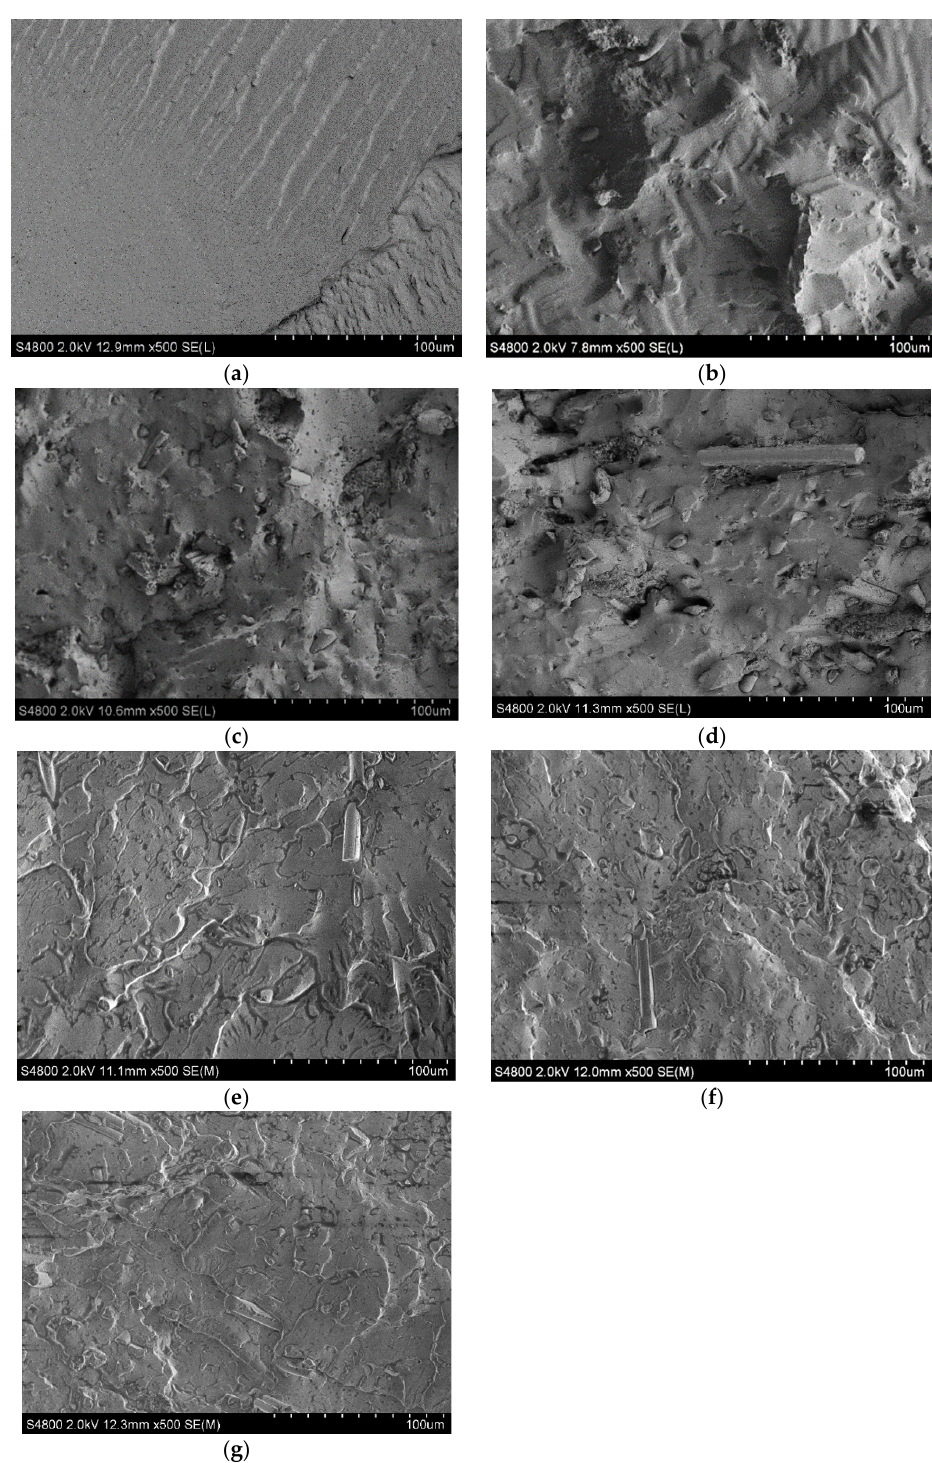
Figure 3. SEM morphology of ( a ) neat PVC, ( b ) 10 wt.% untreated NMPCB/PVC composite, ( c ) 20 wt.% untreated NMPCB/PVC composite, ( d ) 30 wt.% untreated NMPCB/PVC composite, ( e ) 10 wt.% treated NMPCB/PVC composite, ( f ) 20 wt.% treated NMPCB/PVC composite and ( g ) 30 wt.% treated NMPCB/PVC